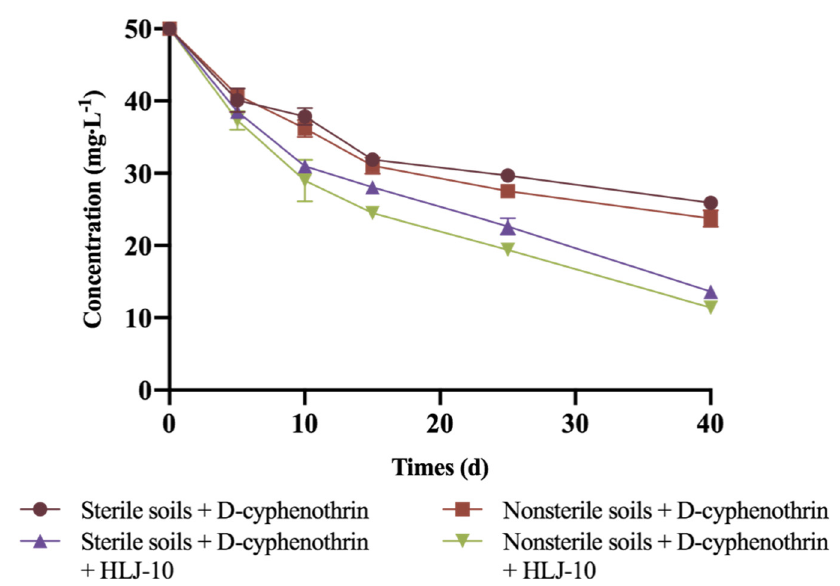
Figure 6. Degradation kinetics of D-cyphenothrin in different soils. Table 6. Kinetic parameters of D-cyphenothrin degradation with Staphylococcus succinus HLJ-10 in sterile and nonsterile